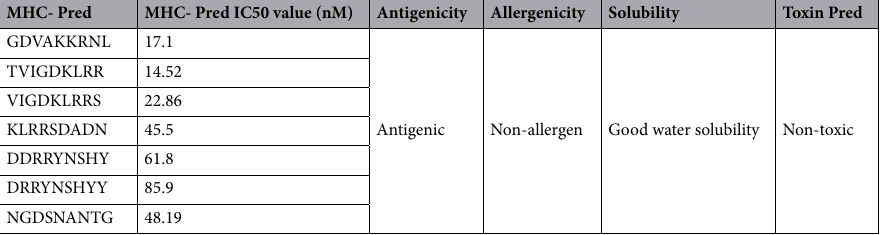
Table 5. List of all shortlisted possible antigenic, non-allergenic, nontoxic, and water-soluble peptides.